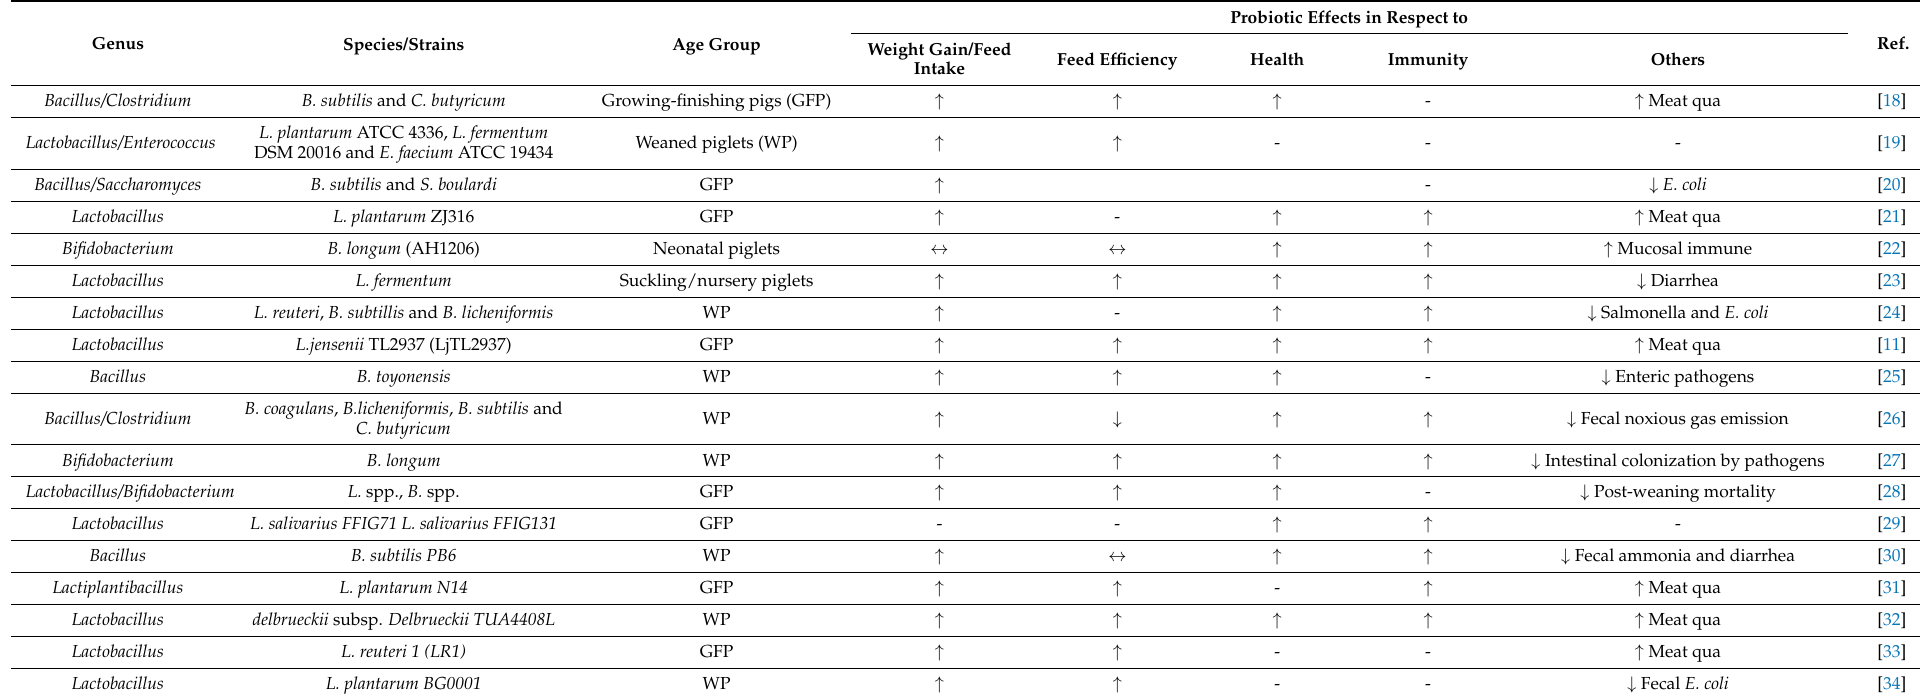
Table 1. Summary of current pig trials (in vivo) measuring the effects of probiotics on health and productivity.